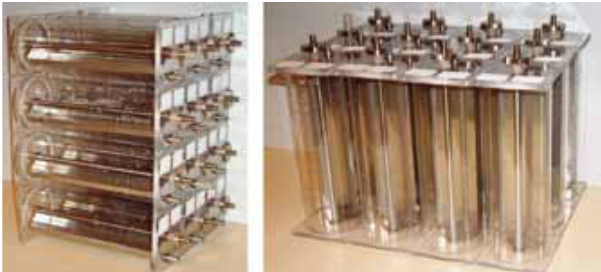
Figure 17: Testing of the world’s first multi-function phyto-bioreactor